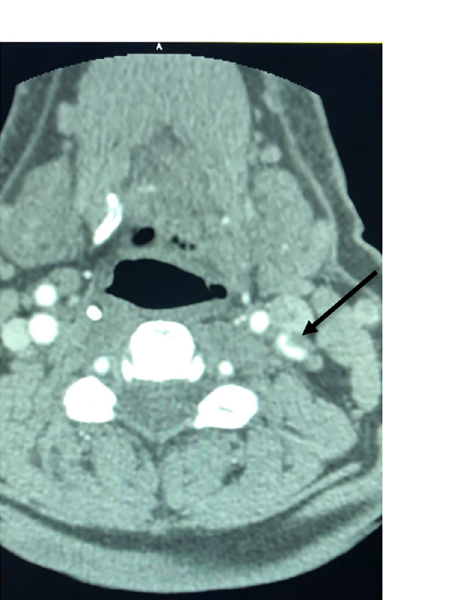
Image 2. Computed tomography demonstrating dissection of the left internal carotid artery depicting “crescent sign” (arrow).